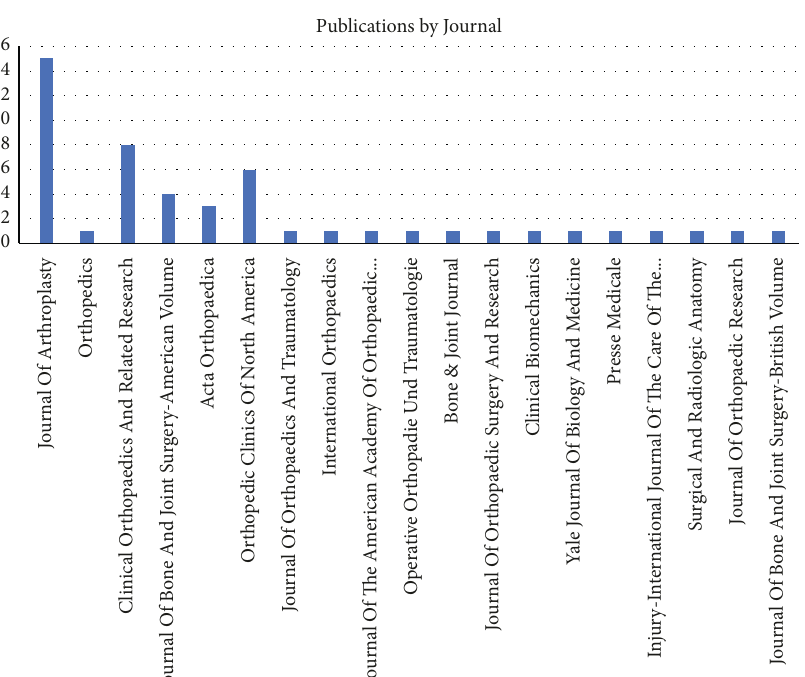
Figure 5: Publication by